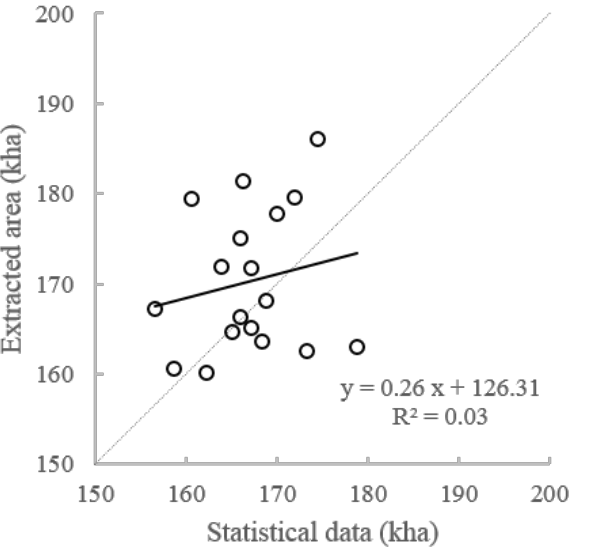
Figure 5. The extracted sugarcane planting area against the 250 m spatial resolution statistical data.